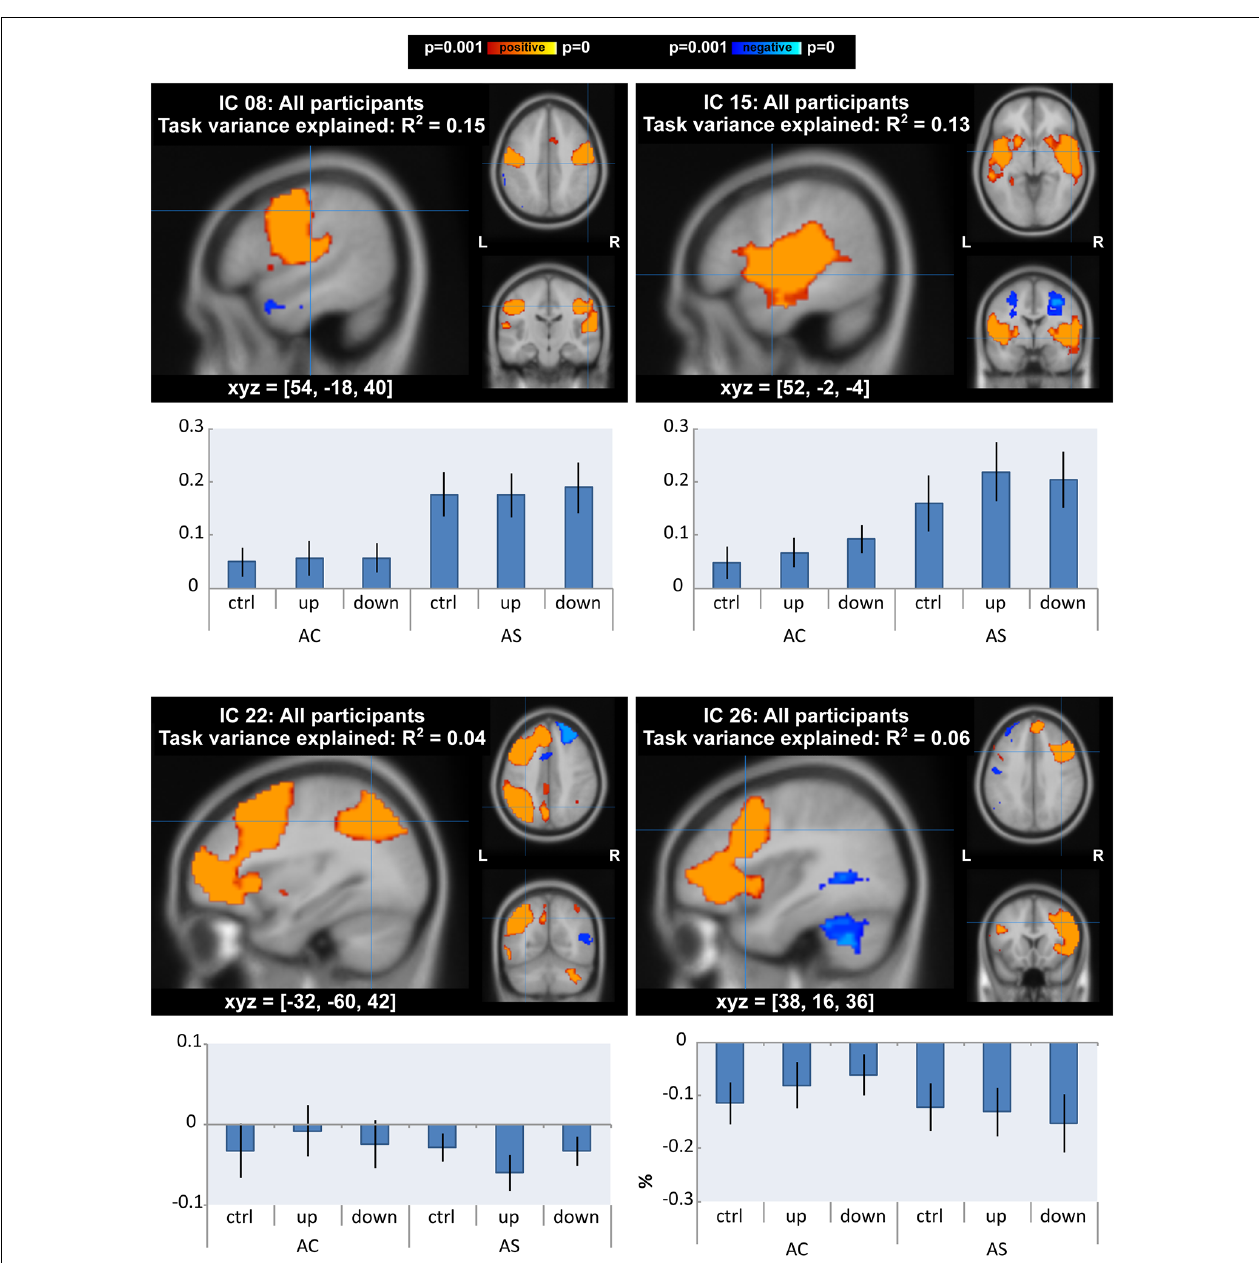
FIGURE 5 | Independent component analysis (ICA) with all participants: components that showed a main effect or interaction between groups/conditions. Spatial maps of components are p < 0.001, corrected for multiple comparisons and using threshold-free cluster enhancement). The top two components (IC 8 and 15) also accounted for the most task variance. Below each map is a bar graph of the mean percent signal change by group and condition within each network.